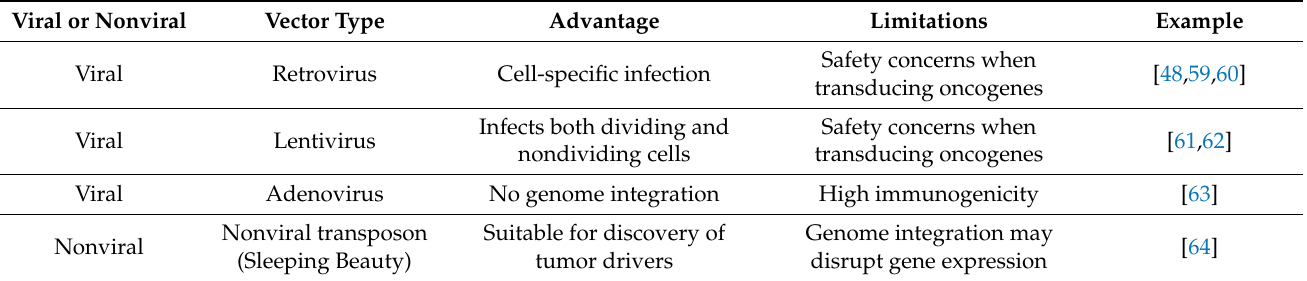
Table 1. Vectors used for gene delivery in LGG models